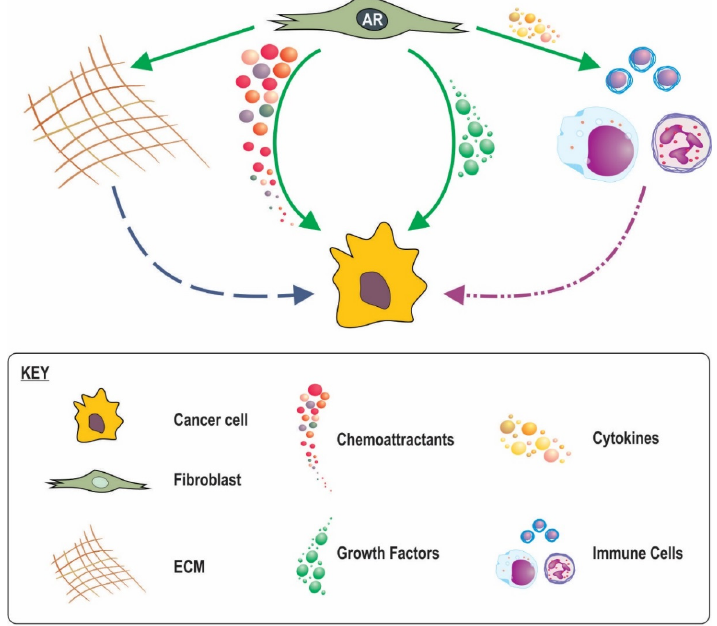
Figure 3. Potential mechanism for fibroblast AR influence on prostate cancer outcomes. AR